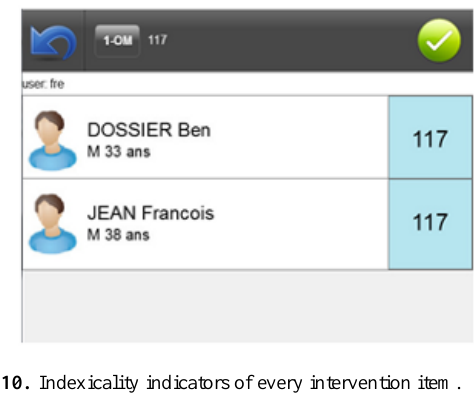
Figure 9. Screen for the selection of the patients in the rooms.